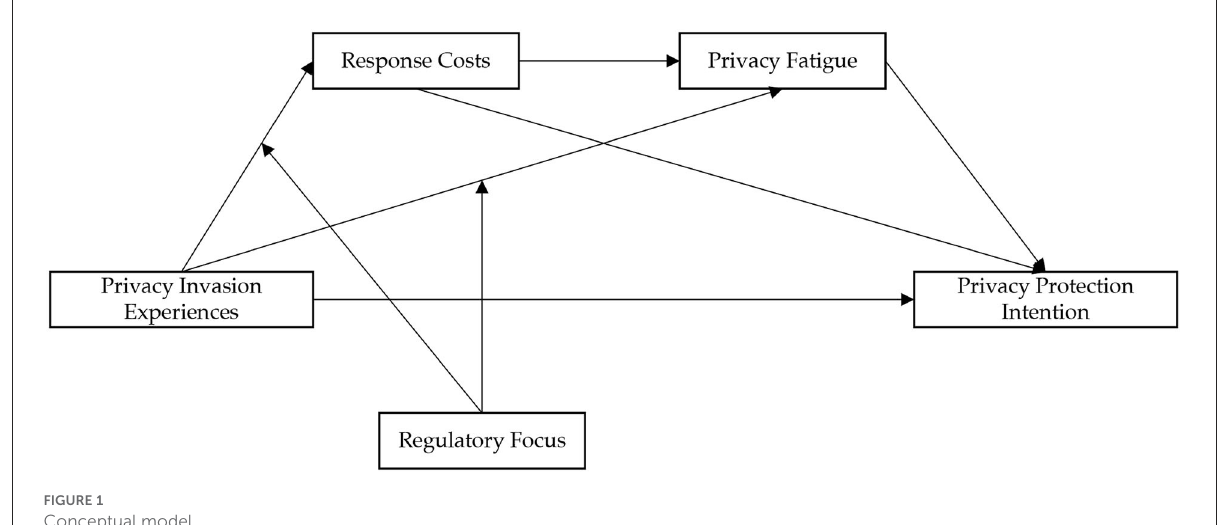
FIGURE1 Conceptual